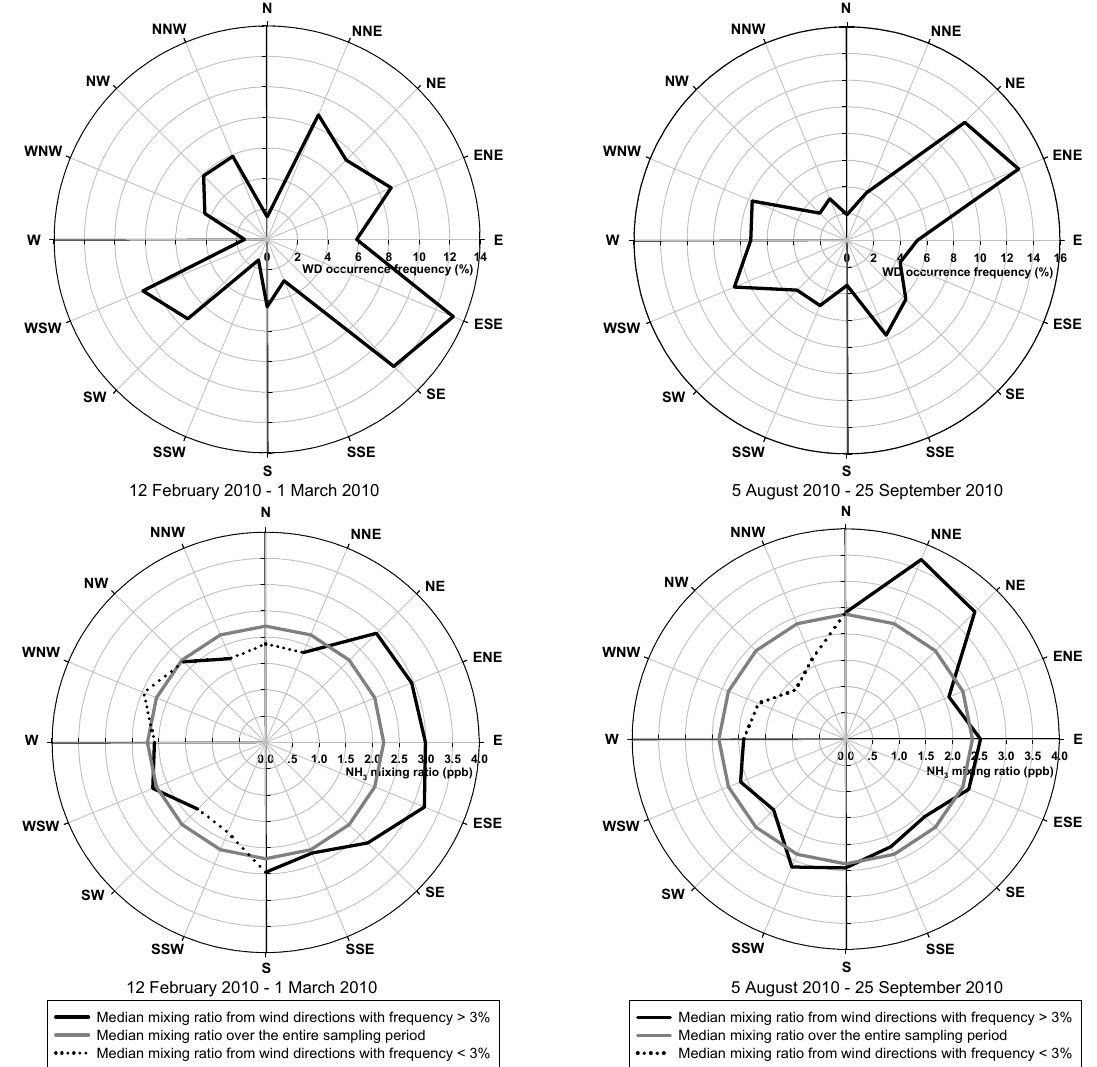
Fig. 8. (a) Wind direction (WD) distributions during morning rush hours (06:00–10:00CST) and (b) the dependence of NH 3 mixing ratios on wind direction.